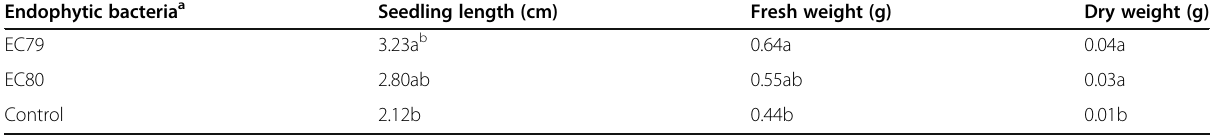
Table 4 Mean parameters of in vivo pitaya seedlings treated with different endophytic bacterial strains Endophytic bacteria a